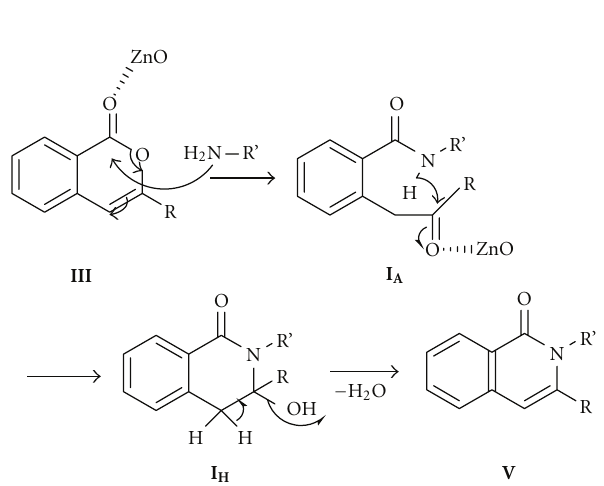
Figure 6: Plausible mechanism for the amination of